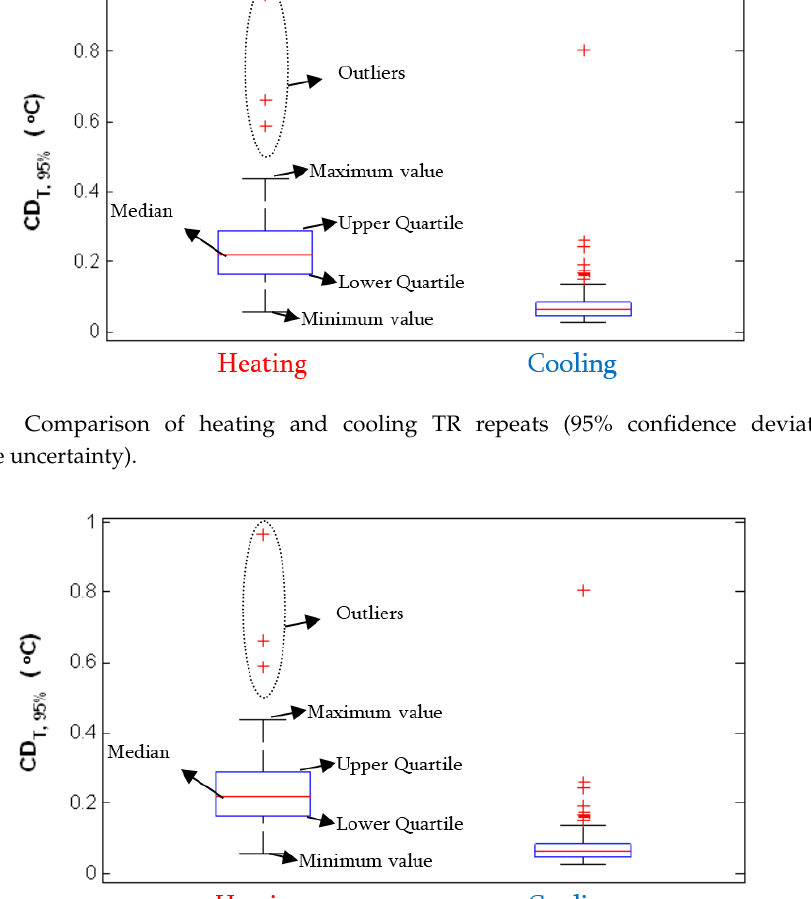
Figure 16. Comparison of heating and cooling TR repeats (relationship between r 2 -value and CD T ,95% ). 3.2. Effect of Sensing Element Samples of the TSF were manufactured using 10 different kinds of sensing element. The TSF samples can be grouped into three ranges of reference resistance, as stated in Table 1. Figure 17 presents the effect of sensing elements on the regression uncertainty (in terms of 𝐶𝐷 𝑇 ,95% ). The 𝐶𝐷 𝑇 ,95% of experimental repeats of all kinds of sample were individually calculated and then grouped according to their sensing elements. The solid bar presents the mean values of 𝐶𝐷 𝑇 ,95% , while the error bar presents the standard uncertainty in the corresponding group of data. The regression uncertainties in the experimental repeats of the TSF samples having high and medium ranges of nominal resistance were found to be less than ±0.13 °C, while in the case of the Cu-based TSF samples, the uncertainties exceeded ±0.18 °C, as shown in Figure 17. This marginal difference can be related to the accuracy of the multimeter.